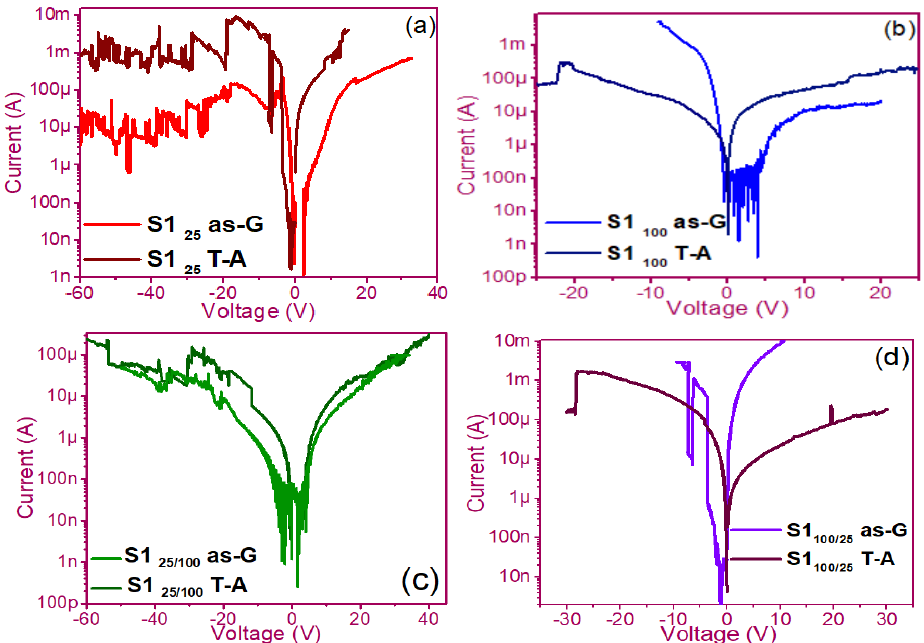
Figure 5. I-V curves ( a ) S1 25 as-G and T-A, ( b ) S1 100 as-G and T-A, ( c ) S1 25/100 as-G and T-A, ( d ) S1 100/25 as-G and T-A.